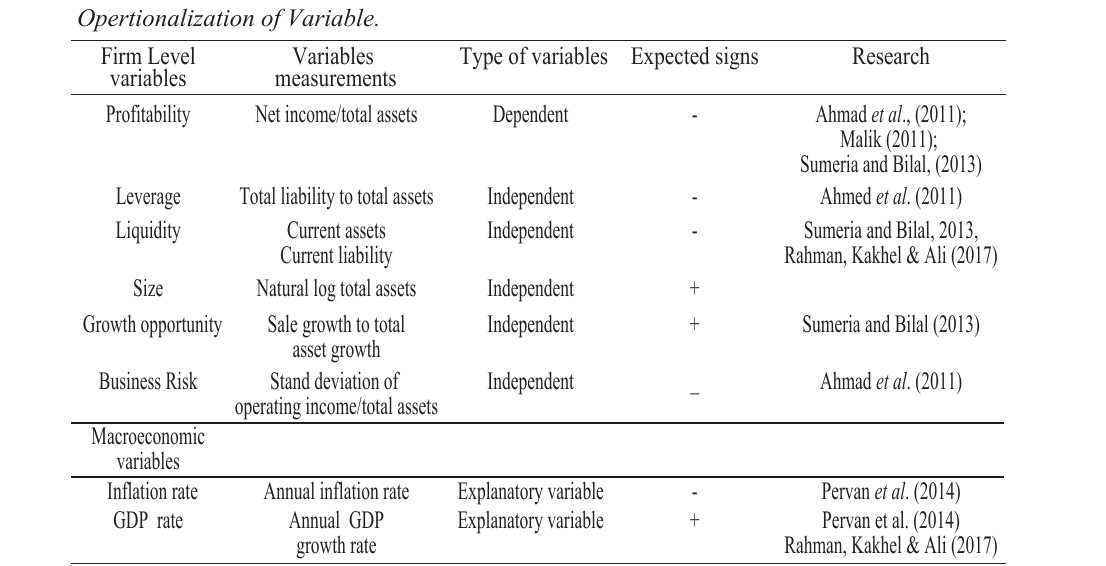
Opertionalization of